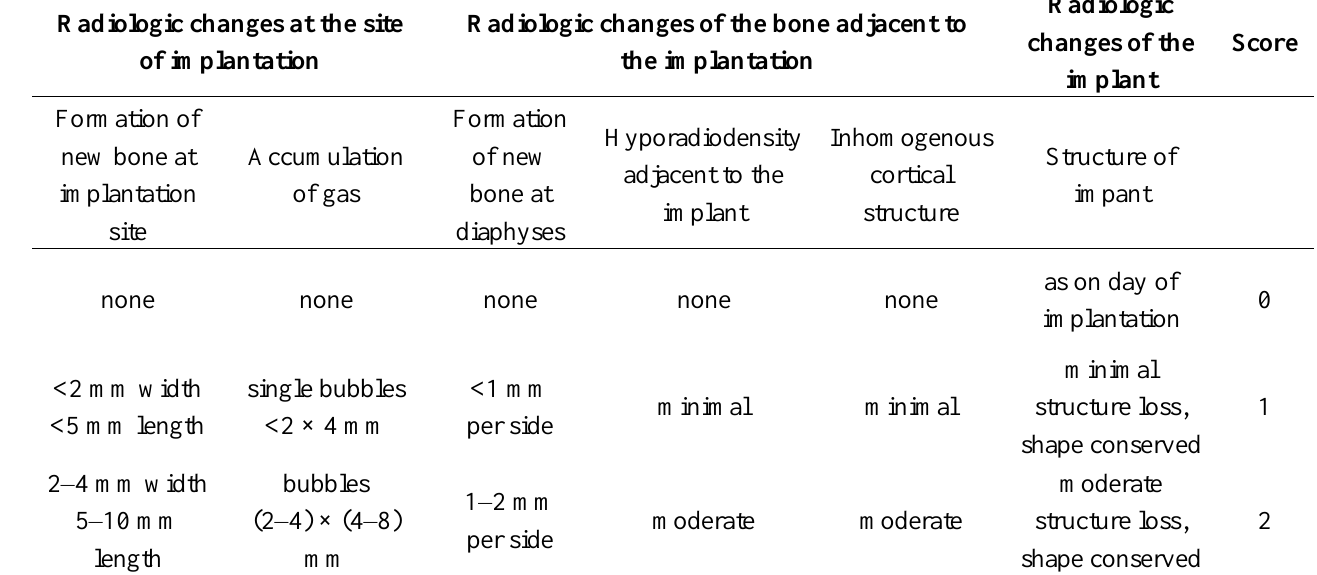
Table 5. Semiquantitative score for the evaluation of radiographs of the tibiae during follow